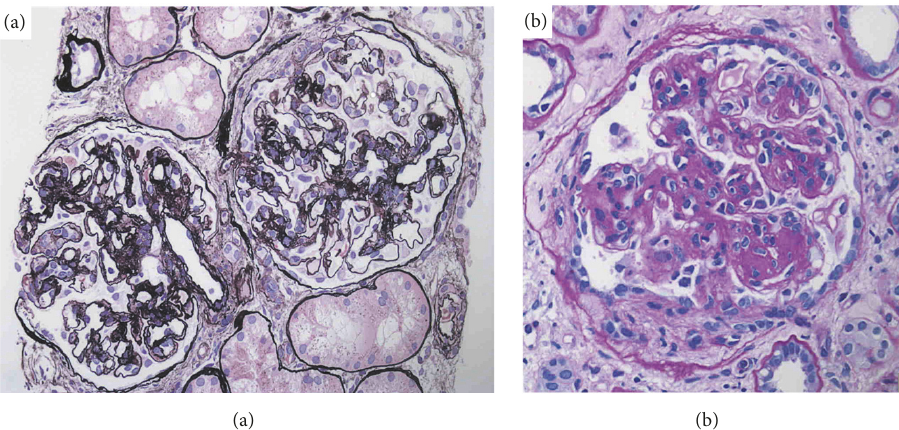
Figure 1: Light microscopy findings. In the renal biopsy specimen, glomeruli showed diffuse double-contours in the glomerular basement membrane and moderateto severefocal endocapillary and mesangial hypercellularity (a). Some nonscleroticglomeruli were accompanied by fibrocellular crescents (b) ((a), periodic acid methenamine silver stain, original magnification 400 × ; (b), periodic acid-Schiff stain, original magnification 400 ×